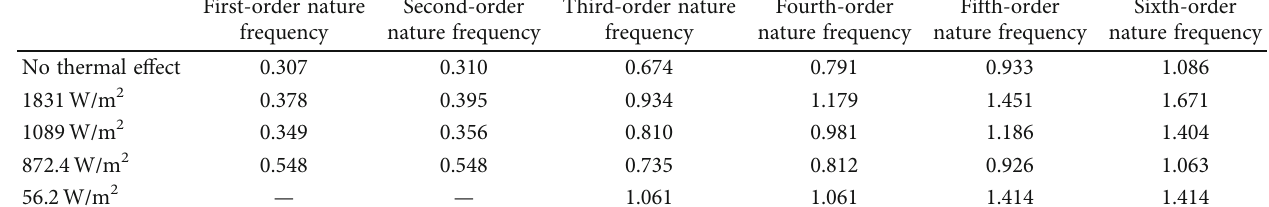
Table 4: Nature frequencies of the membrane antenna structure under di ff erent heat fl